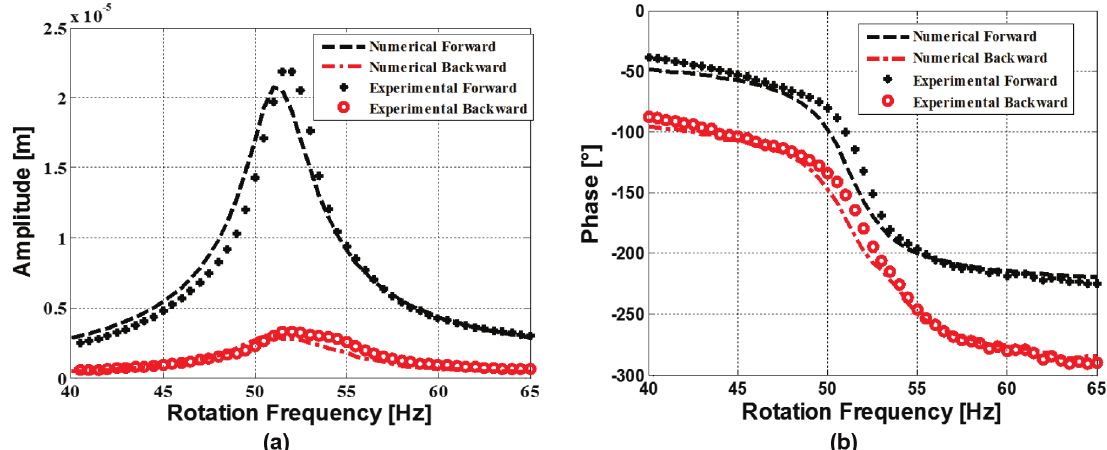
Figure 16 - Directional response of the system (bearing B2 position) for Case 1 – a) Amplitude and b) Phase.